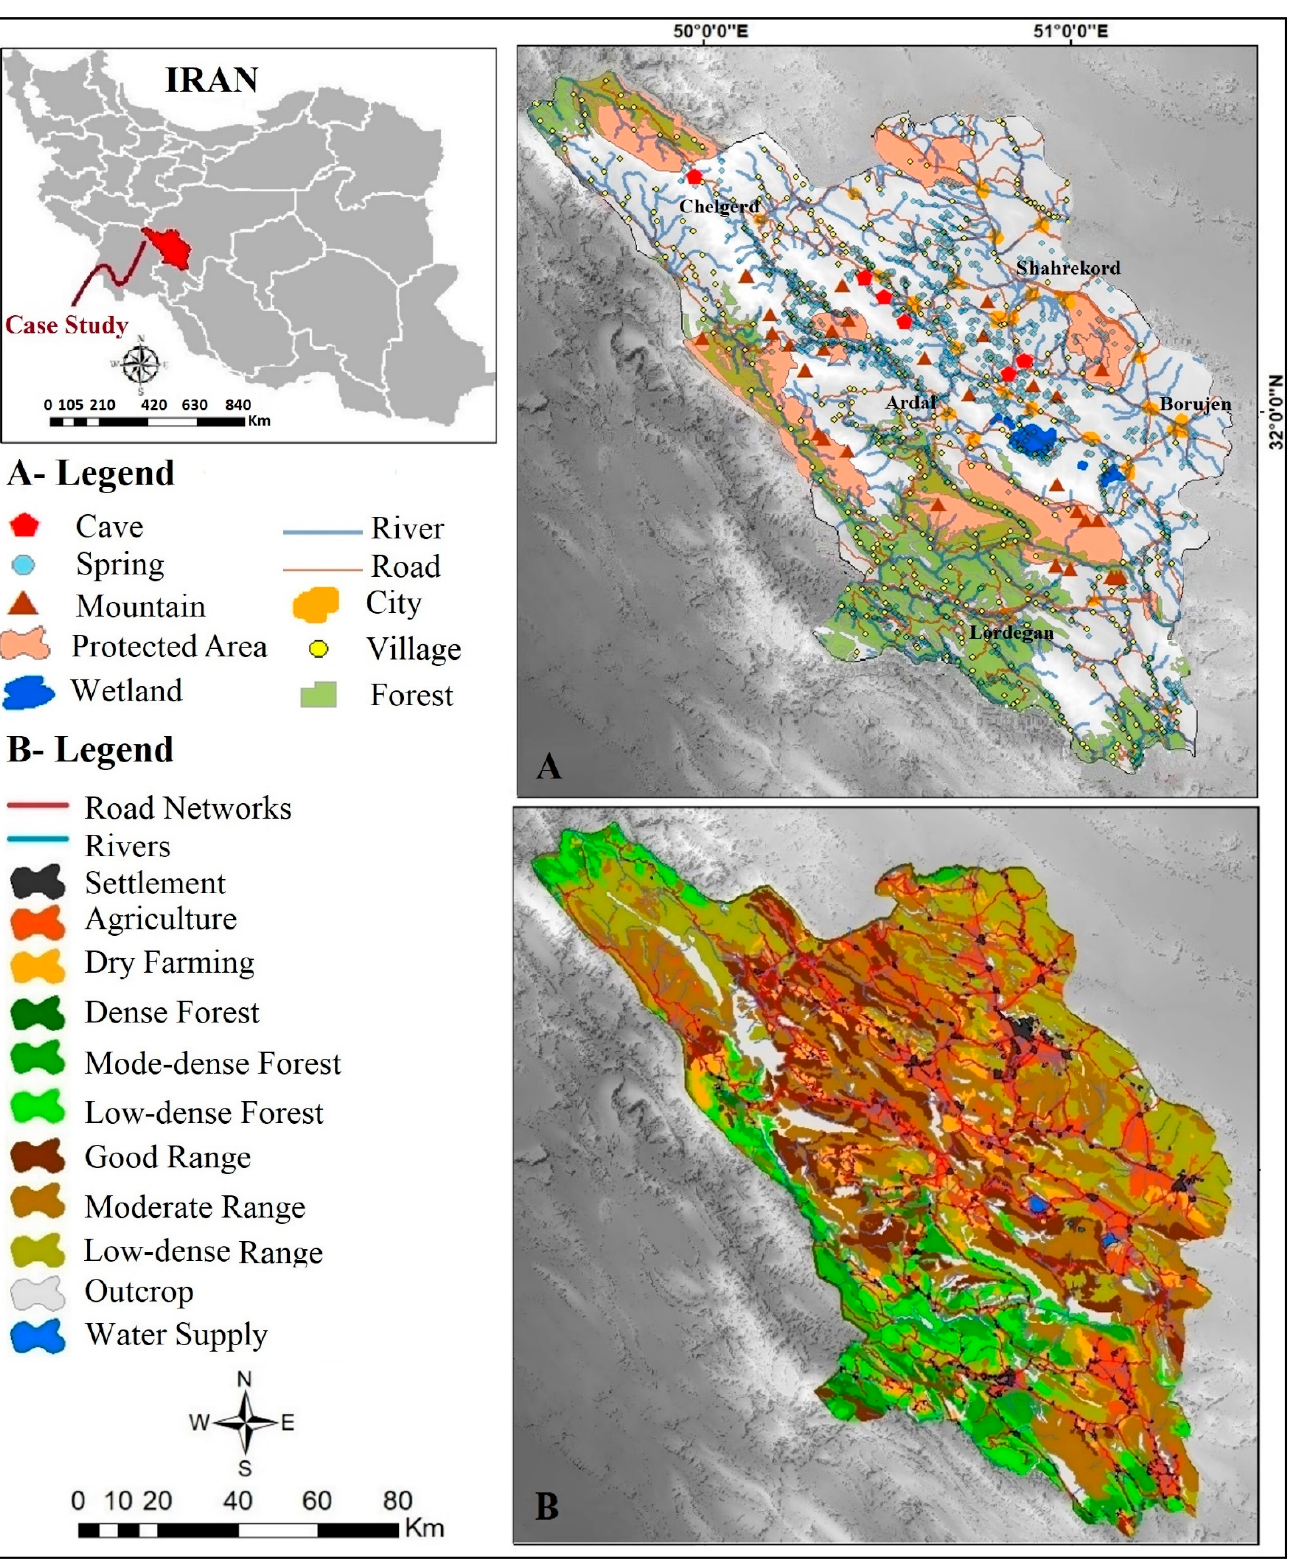
Figure 2. Position of the study area: ( A ) locations of the tourist attraction factors, ( B ) land use/cover map.